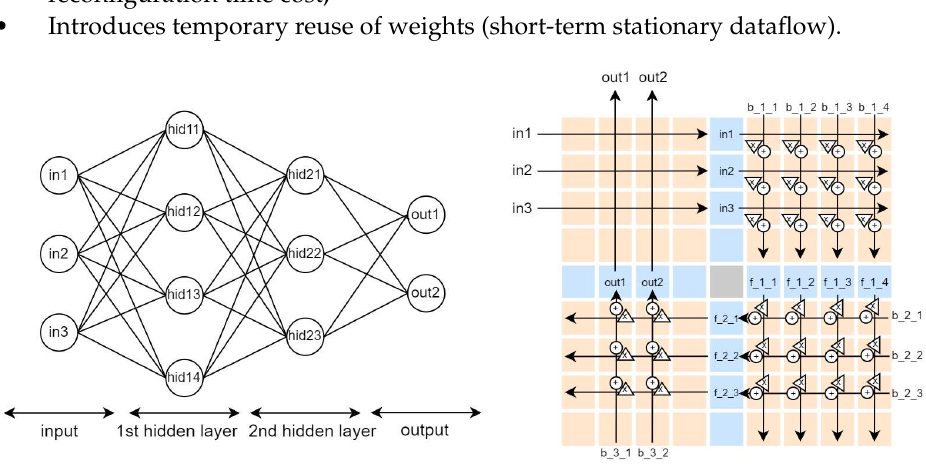
Figure 9. Multi-cycle processing of NN in the segmented RCE.